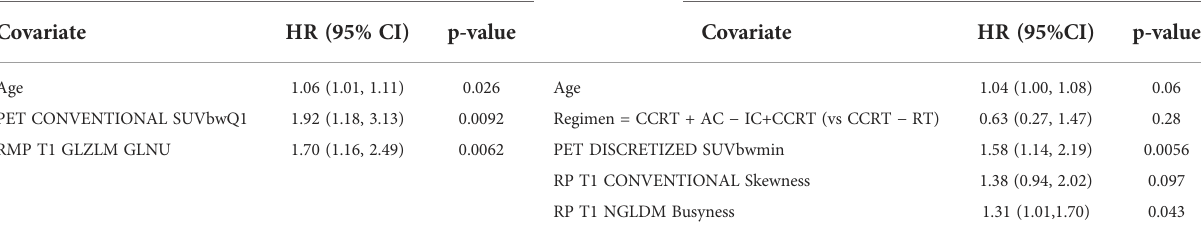
TABLE 5 Final prognostic models for PFS and OS. Final Model for